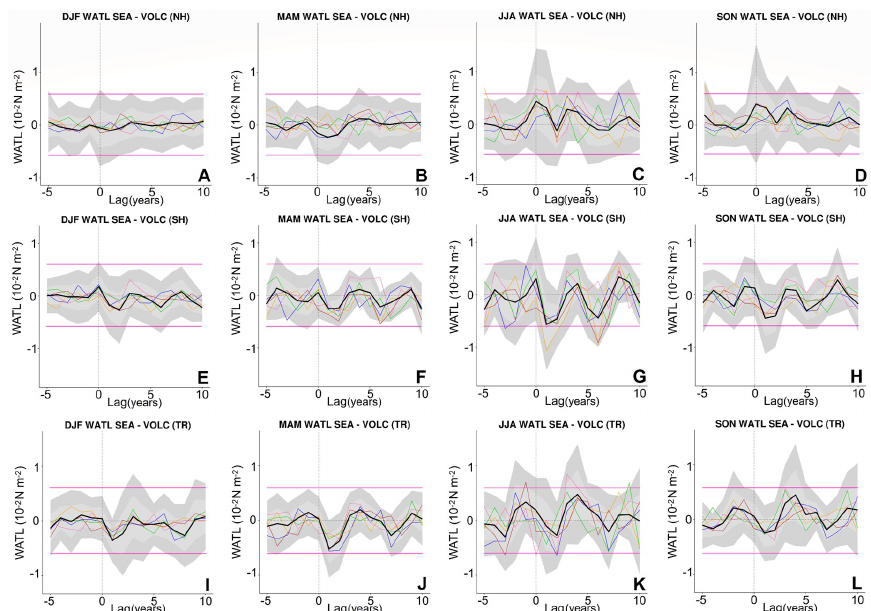
Figure 4. VOLC SEA for WATL wind stress seasonal anomalies (10 − 2 Nm − 2 ), calculated considering the volcanic eruptions listed in Table 1, for five years before the eruption and ten years after the eruption. Horizontal: class of the eruptions (NH—( A – D ); SH—( E – H ); and TR—( I – L )); Vertical: seasonal SEA (December to February—DJF; March to May—MAM; June to August—JJA; and September to November—SON). Lines in colors correspond to the individual ensemble members, and black thick line refers to the ensemble mean. Light shaded gray corresponds to one standard deviation, and dark shaded gray corresponds to two standard deviations. Magenta solid line corresponds to one standard deviation of the CTRL run. Atmosphere 2018 , 9 , x FOR PEER REVIEW